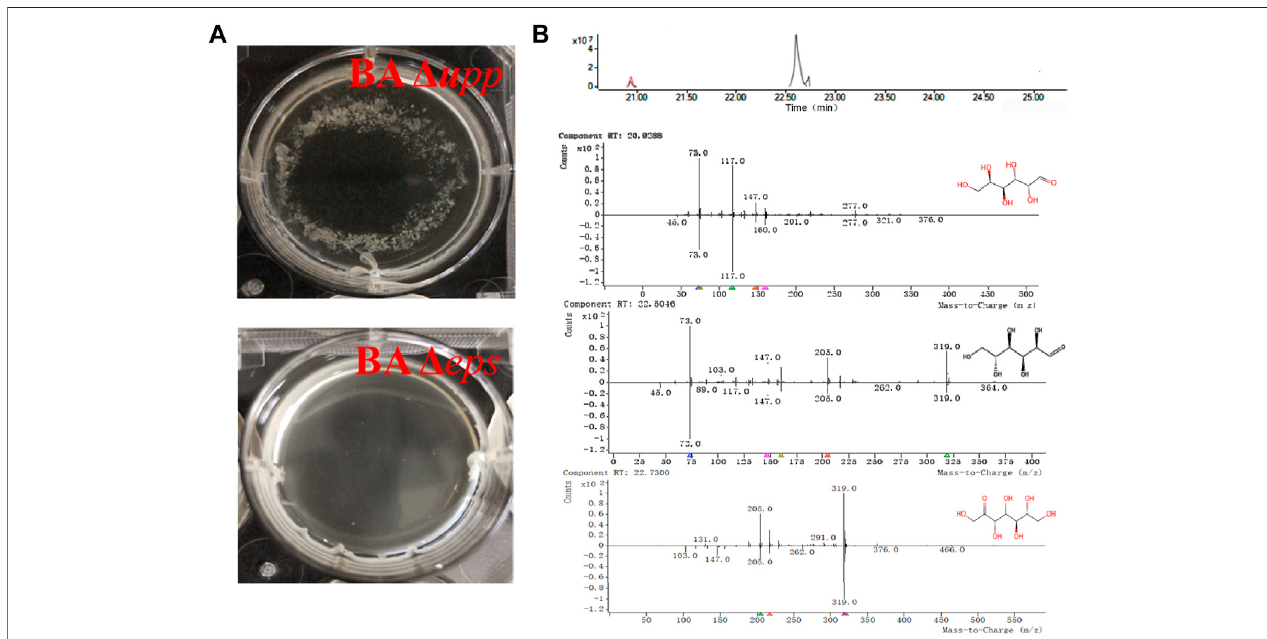
FIGURE 6 | Con fi rmation of eps cluster disruption by comparison of phenotypic differences and identi fi cation of extracellular polysaccharides using GC-MS in B. amyloliquefaciens Δ upp and Δ eps . (A) Fermentation brothwithgranulated thallusofthe BA Δ upp strainand exquisitefermentation brothofthe BA Δ eps strain. (B) Total ion chromatogram and mass spectrum of the major monosaccharides detected in B. amyloliquefaciens . A sample represents the processed product of the EPS- producing strain (BA Δ upp ) to be detected by GC-MS; control represents the processed product of the fermentation medium to be detected by GC-MS; b-1: glucose was identi fi ed by mass spectrometry with a matching quality of 96.5% compared with the NIST-17 Database; b-2: galactose was identi fi ed by mass spectrometry with a matching degree of 92.4% compared with the Database; b-3: sedoheptulose was identi fi ed by mass spectrometry with a matching degree of 90.27% compared with the